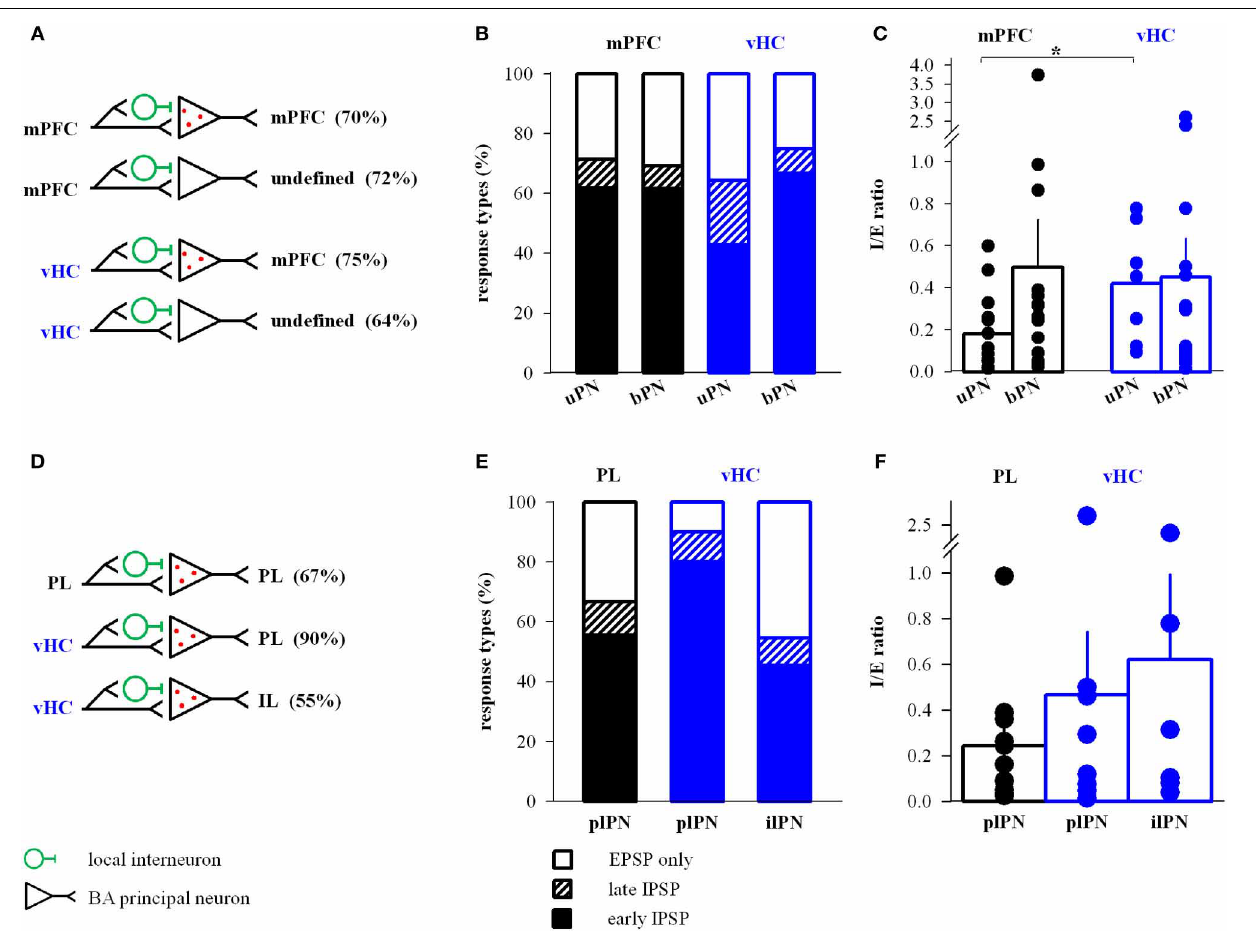
FIGURE 8 | mPFC and vHC connectivity with and properties of inputs to BA projection neurons. (A) Scheme of projections observed onto retrobead-labeled mPFC-projecting (bPN) and unlabeled BA principal neurons (uPN). (B) Relative distribution (%) of purely excitatory (open bars) and additional inhibitory response types (early IPSP: closed bars, late IPSP: striped bars) in uPNs and bPNs. Occurrence of inhibitory response types for mPFC → uPN: early 62%, late 10%, n = 21; mPFC → bPN: early 62%, late 8%, n = 26; vHC → uPN: early 43%, late 21%, n = 14; and vHC → bPN: early 67%, late 8%, n = 24. No significant differences were found between inputs or cell types (Fisher’s Exact Test, p > 0 . 05). (C) Summary graph of inhibition-to-excitation ratio (I/E ratio) in uPNs and bPNs for mPFC (black) and vHC inputs (blue). All values are in Table 2 . Individual data points illustrate the high variability of I/E ratios. Synaptic inputs onto uPNs showed significantly lower I/E ratios for mPFC inputs